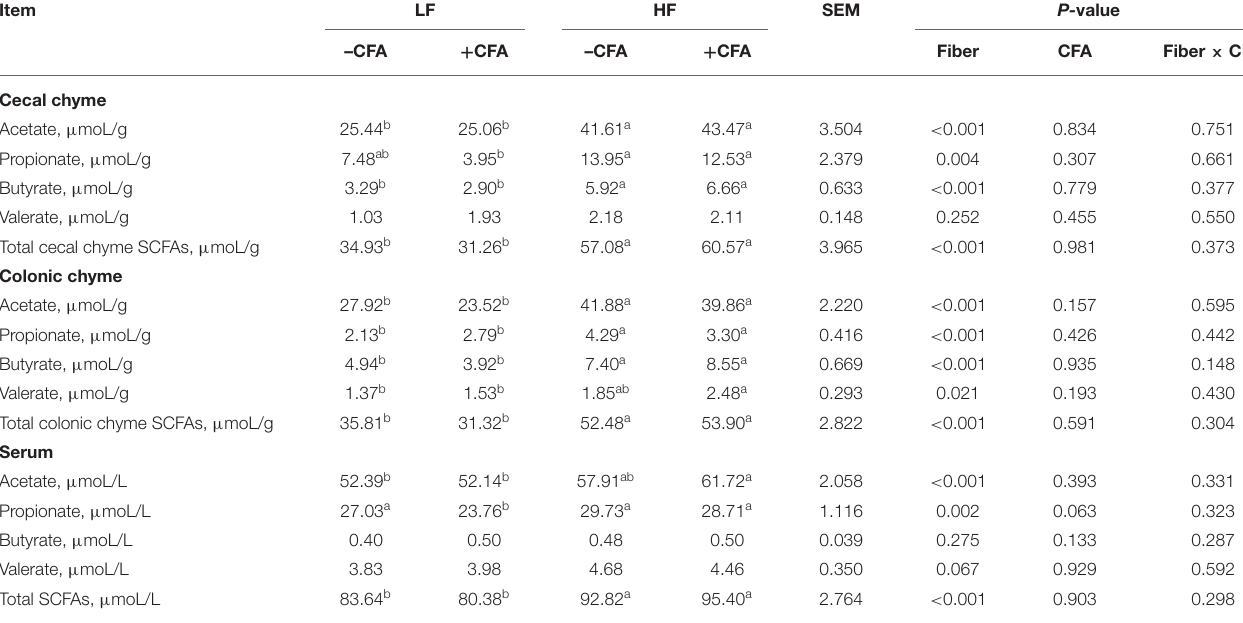
TABLE 4 | Effects of dietary fiber on the content of short-chain fatty acids in chyme and serum after CFA challenge of piglets c . Item